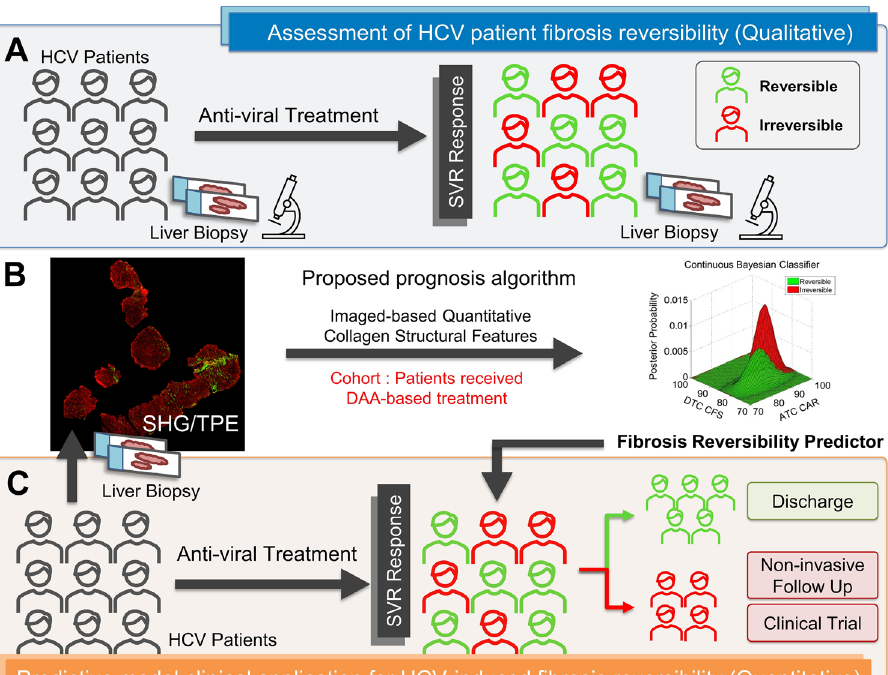
Figure 1. Prediction of HCV-induced liver fibrosis reversibility after SVR has significant clinical value. ( A ) HCV patient liver biopsies were taken pre-SVR and post-SVR for pathologists to assess the fibrosis reversibility. Currently, we lack efficient prognostic features that can stratify the patients for the appropriate interventions. ( B ) Liver biopsy images were scanned using TPE and SHG techniques and then processed using in-house computational algorithms. The features were selected to prototype a predictive model to classify the patients. ( C ) The desired predictive model stratifies the patients as either irreversible or reversible, indicating which patients can be discharged, retained for non-invasive follow up, or enrolled in a clinical